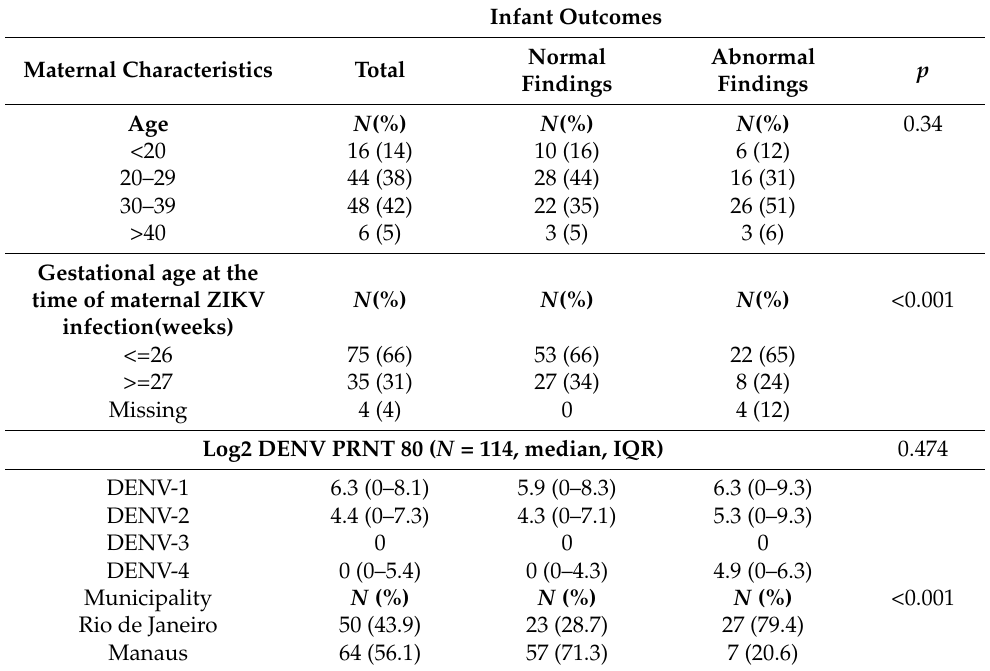
Table 3. Maternal characteristics and neonatal outcomes.